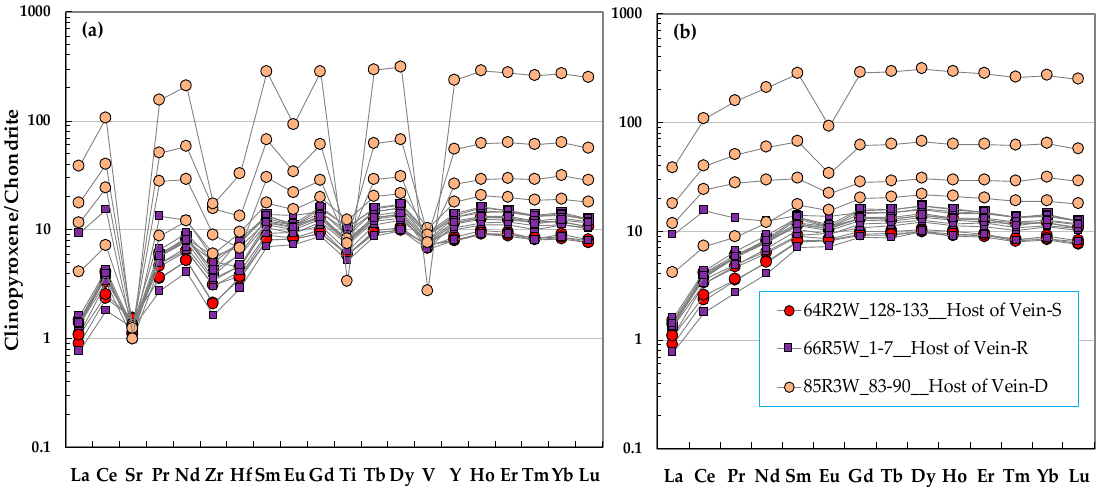
Figure 11. Chondrite-normalized trace ( a ) and rare earth element (REE) ( b ) abundances of clinopyroxenes in the host gabbros—Hole U1473A. Normalizing values are from Reference [37].